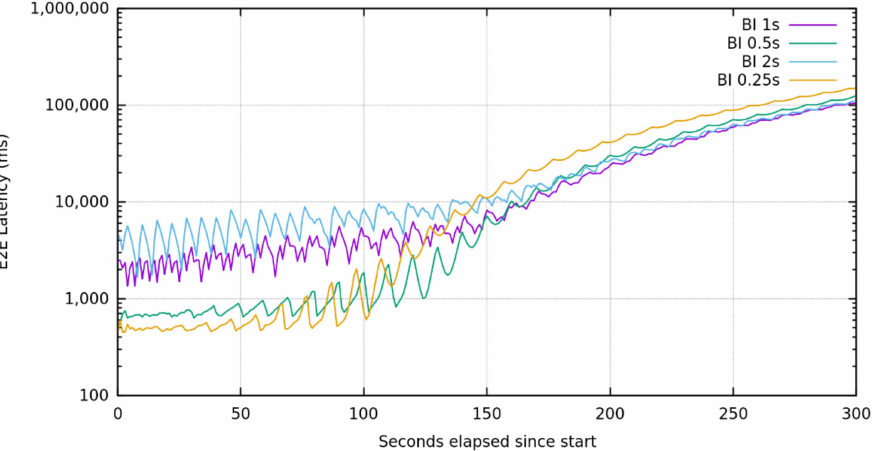
Figure 8. Average end-to-end latency in logarithmic scale when variating the batch interval (BI) in Spark Streaming and submitting an increasing number of messages from 0 to 10,000 in a time-lapse of 5 min.